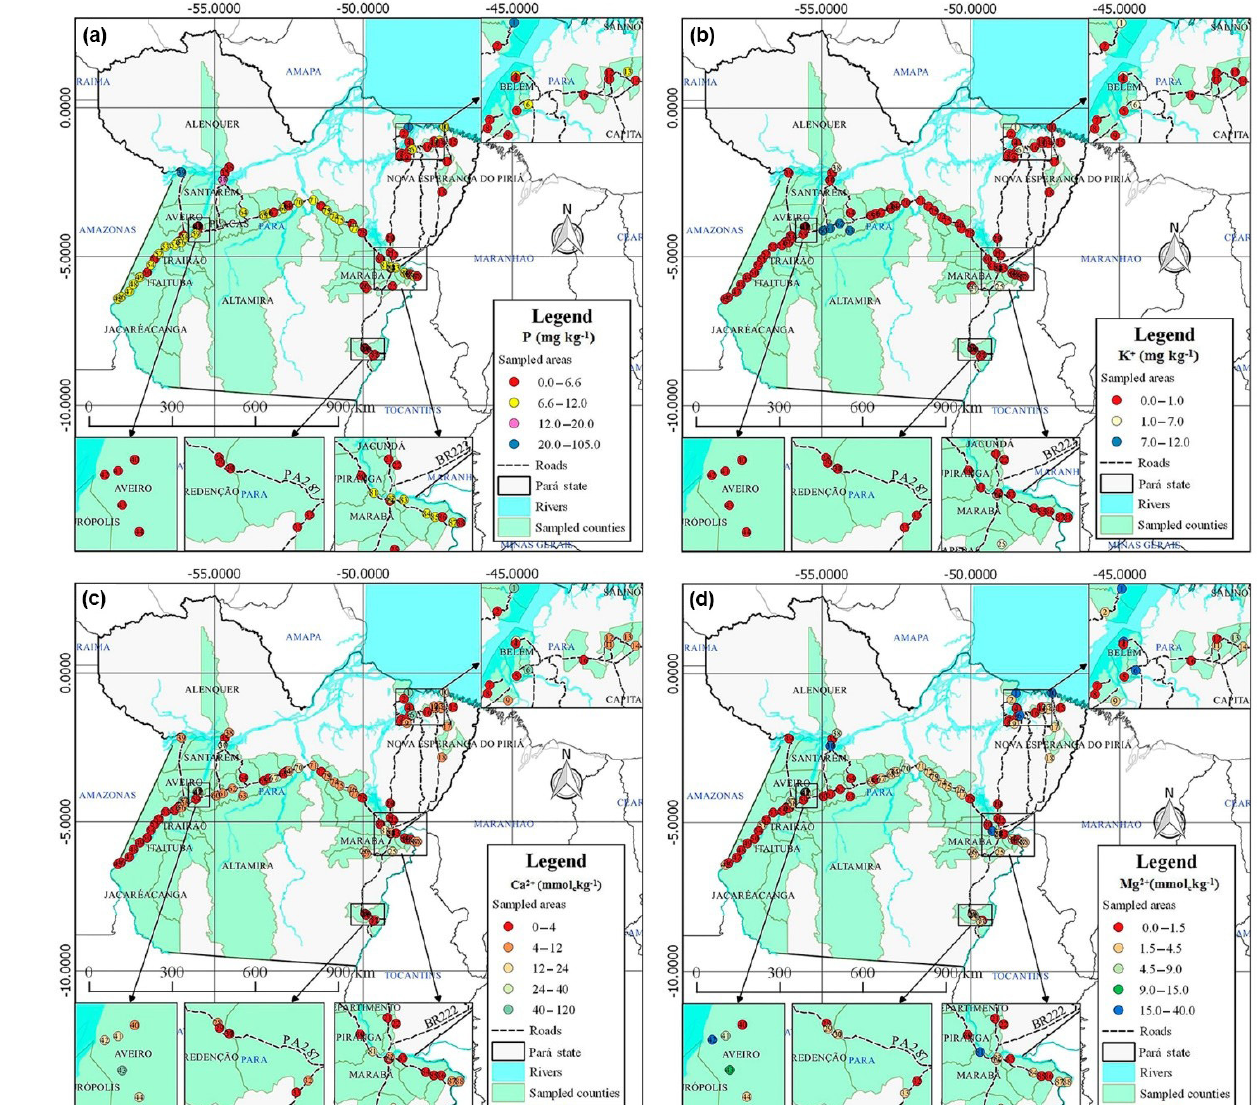
Figure 5. Spatial distribution map of P (a) , K (b) , Ca 2 + (c) , and Mg 2 + (d) of the soils of the state of